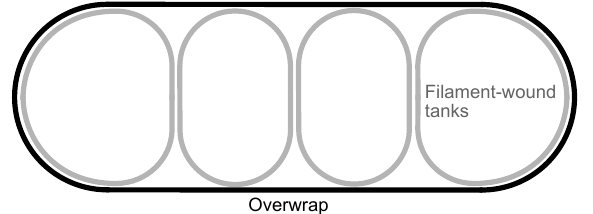
Figure 1. Schematic of the tank design by Thiokol, USA [26,27].